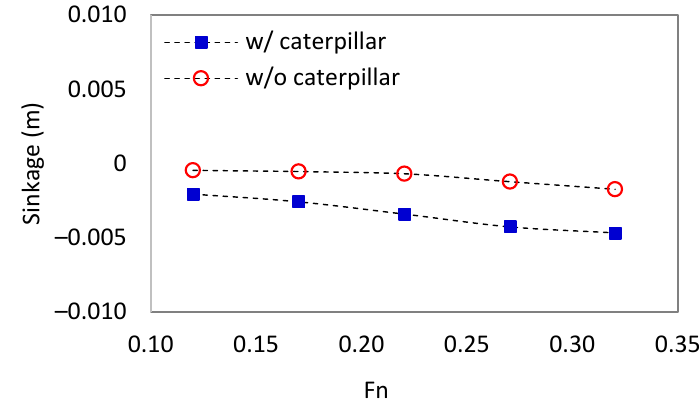
Figure 7. Sinkage for the vessels w/and w/o caterpillars.